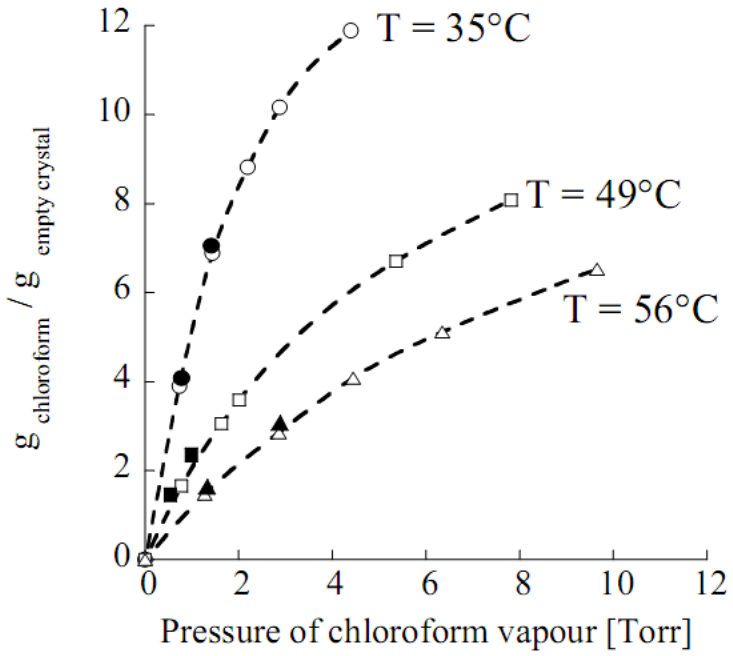
Figure 5. Chloroform sorption isotherms in the crystalline phase of s-PS δ -form films at T = 35, 49 and 56 °C. Lines represent fitting by Langmuir equation. Full marks are simulation values by GCMC. Data taken from reference [84].